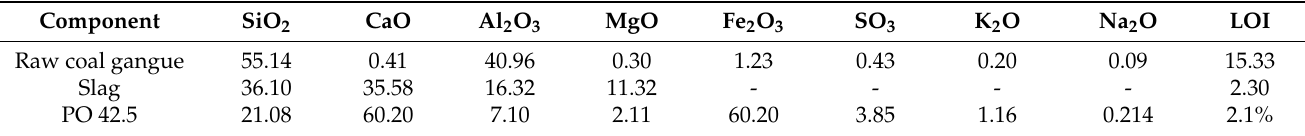
Table 1. Primary compositions of Portland cement, slag, and raw coal gangue